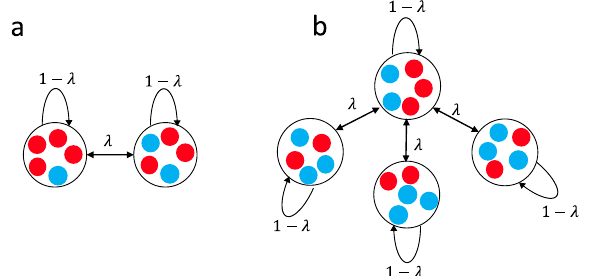
Figure 1. Network of populations; the population consists of well-mixed subpopulations coupled through migration ( a ) two-patch meta-population with local patch size N 1 = N 2 = 5 , ( b ) meta-star with M = 4 patches and local population size N / M = 5